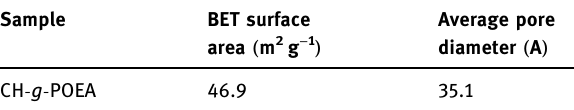
Table 1: BET analysis of the CH - g - POEA Sample BET